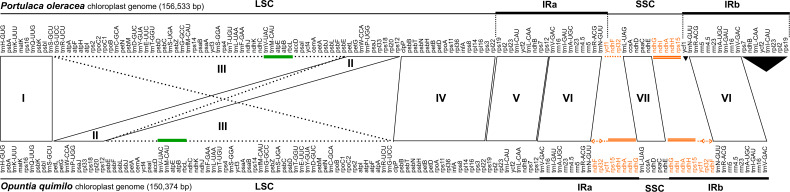
Plastid genome structure and gene order in Opuntia quimilo compared with purslane (Portulaca oleracea). Purslane has the canonical order typical of most angiosperms. For simplicity, the circular map has been linearized. Green line highlights the trnMCAU-rbcL synapomorphic inversion of Cactaceae, which in O. quimilo also includes the trnVUAC gene. Regions I, IV, V, VI, and VII are colinear in both plastomes. Region II is colinear but is translocated in the O. quimilo plastome, while region III is inverted and translocated. Region V comprise the genes that are typically in the IR region but are translocated to the large single copy in O. quimilo. Genes highlighted in orange are those typically found in the SSC but transferred to the IR region in O. quimilo. Orange dashed line indicate the double inversion on the ycf1-rpl32 genes, placing ycf1 gene adjacent to rpl32. Black triangles represent duplicated genes present in purslane but absent in O. quimilo; LSC, large single-copy region; SSC, small single-copy region; IR, Inverted repeat.